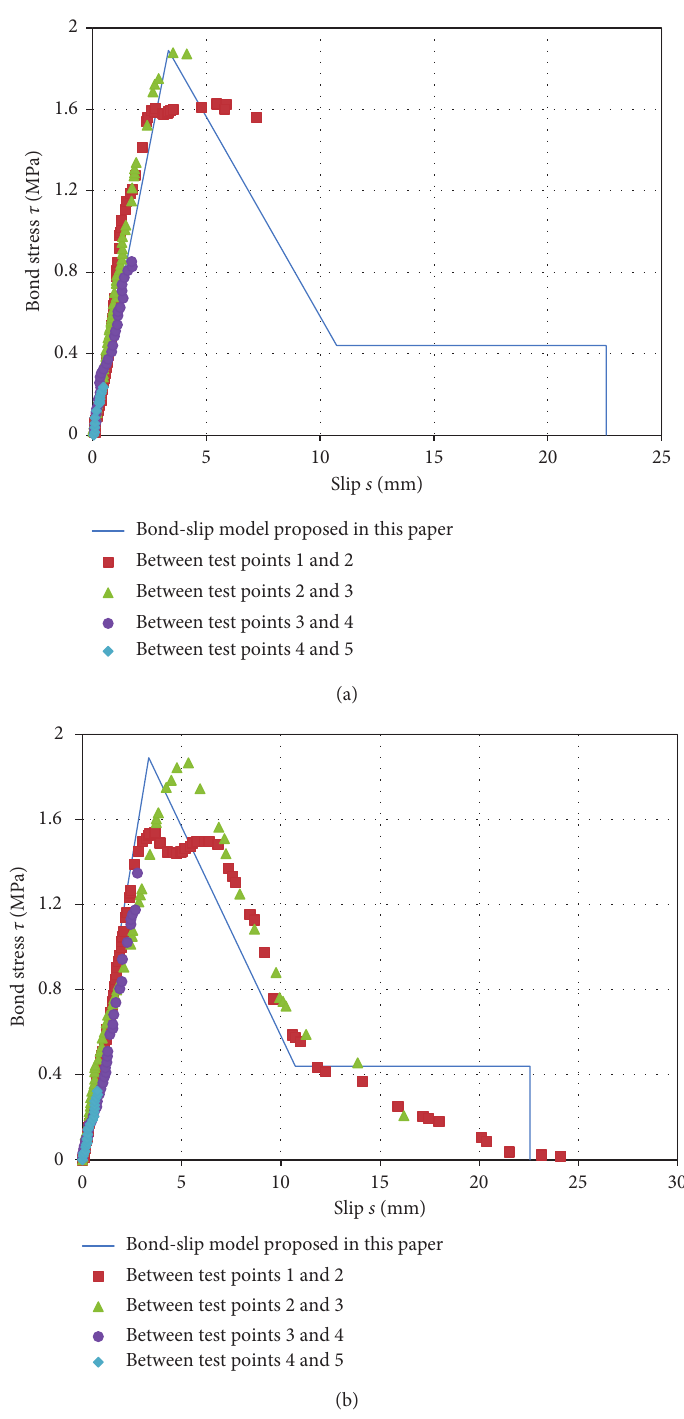
Figure 20: The comparison of the measured data of sheer stress and slip between bamboo-modified slurry interface bond-slip models at different anchorage depths. (a) Anchorage length L < L eff (CB-L-1500b). (b) Anchorage length L ≥ L eff